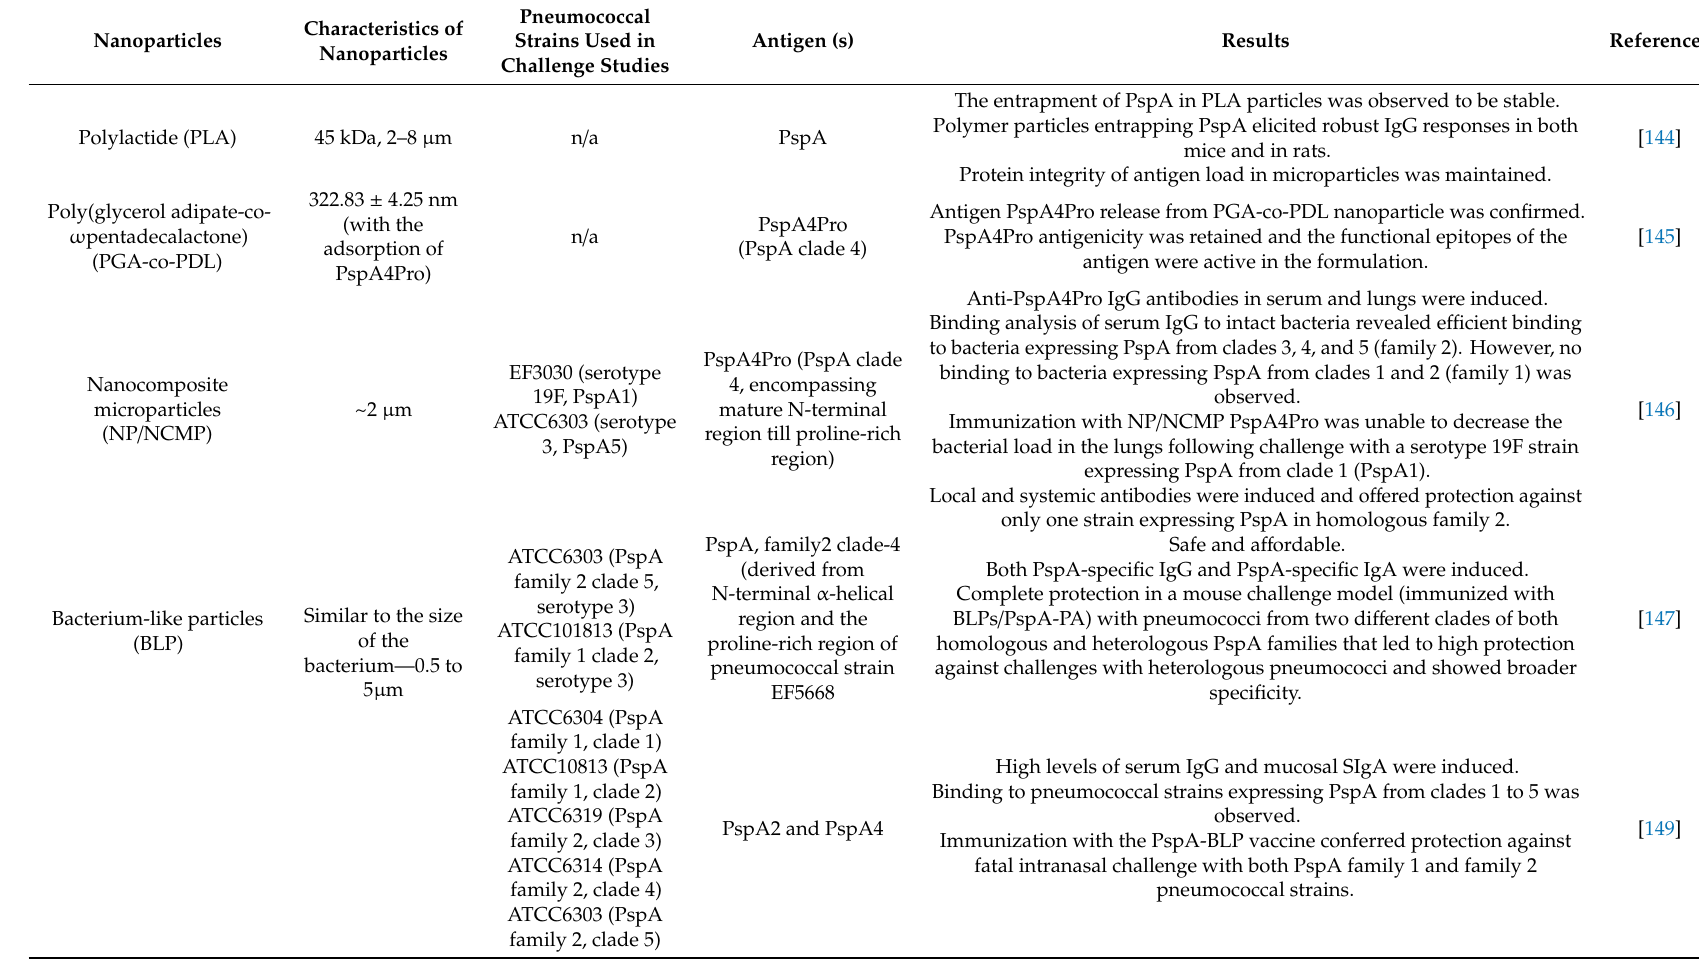
Table 2. Microparticles and nanoparticles for Pneumococcal antigen